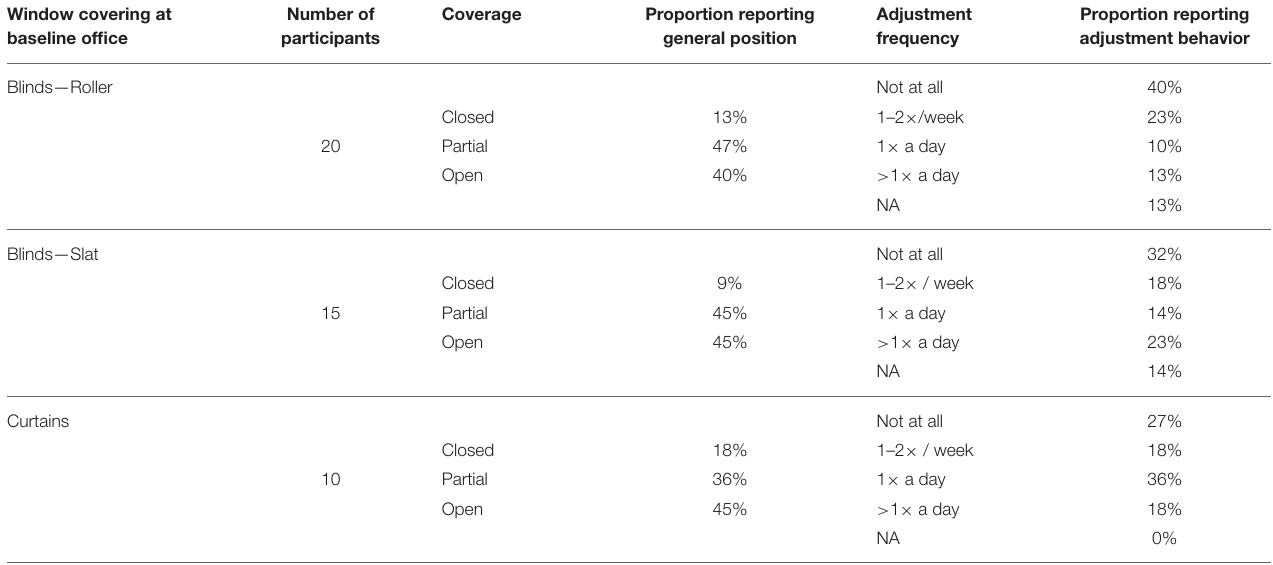
TABLE 1 | Window occlusion and adjustment conditions reported by participants while in their typical office environment during Weeks 1 and 4. Window covering at baseline